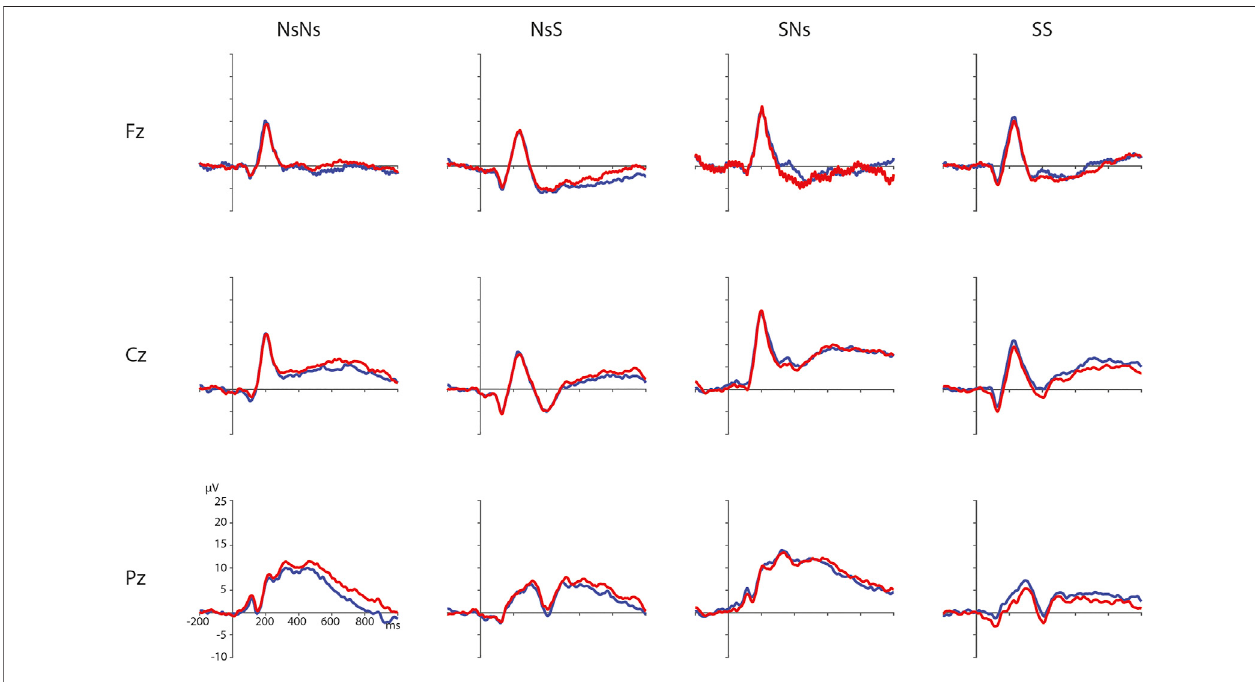
FIGURE 2 | Distance effects per task on electrodes Fz, Cz, and Pz (electrodes chosen for illustration purposes only) with ratio 0.5 in blue and ratio 0.7 in red.